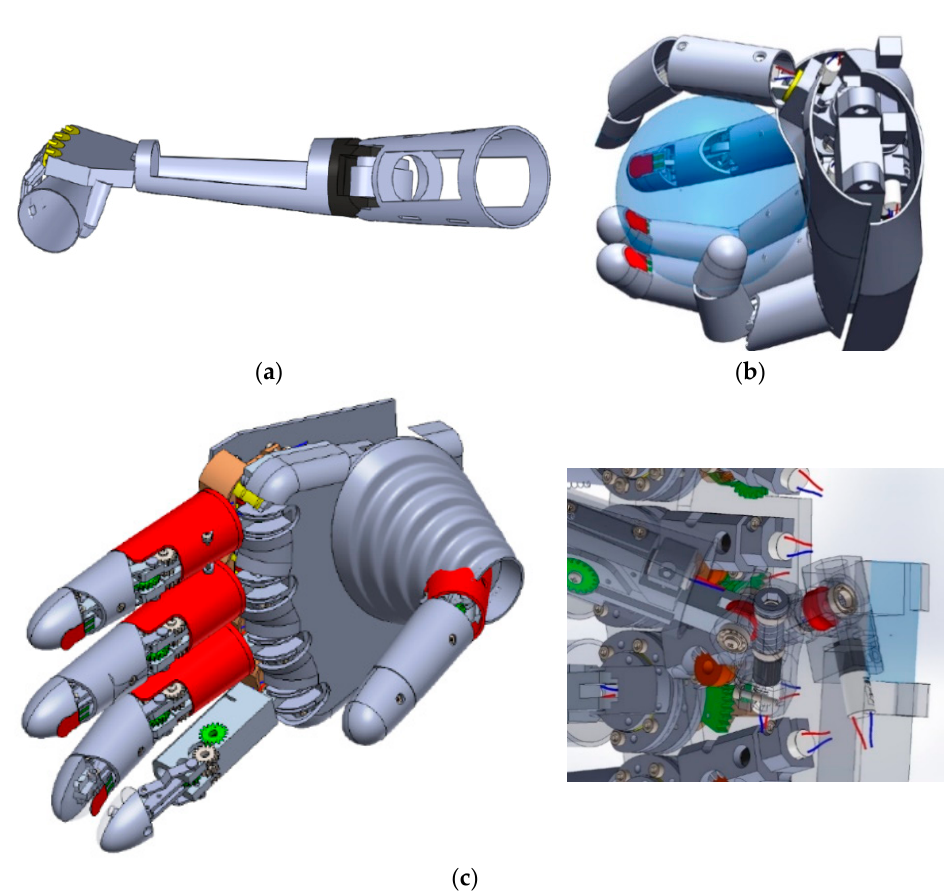
Figure 13. Mechatronic system design: ( a ) first design type, ( b ) intermediate design type, ( c ) up to date design—motion transmission components